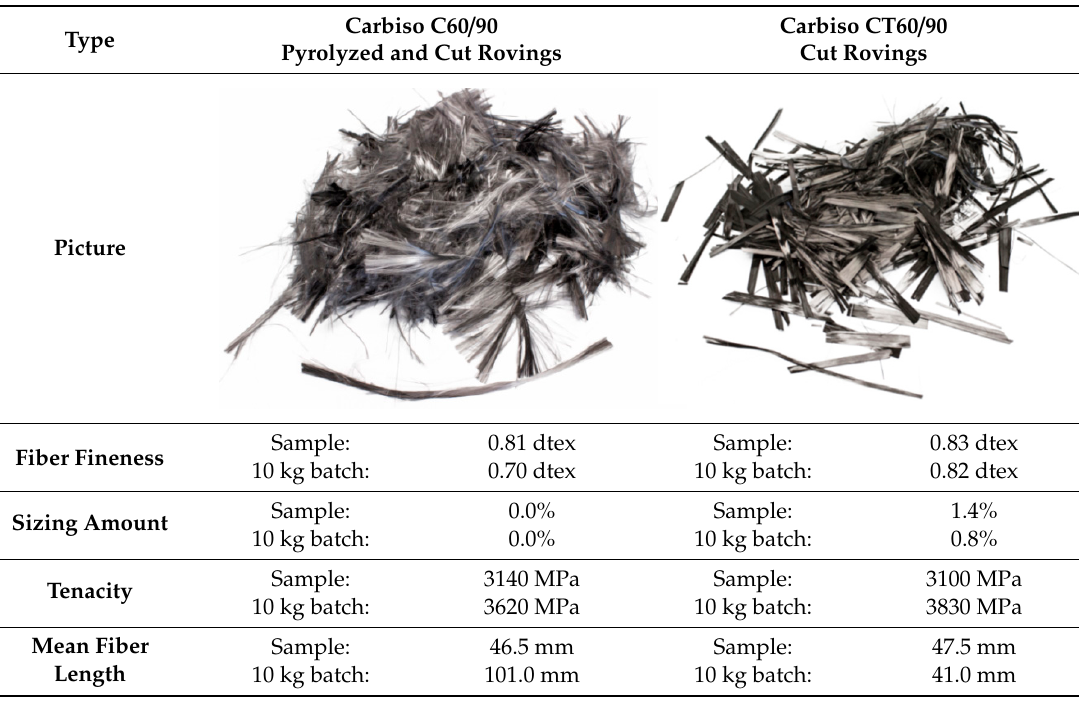
Table 1. Comparison of the recycled fibers.